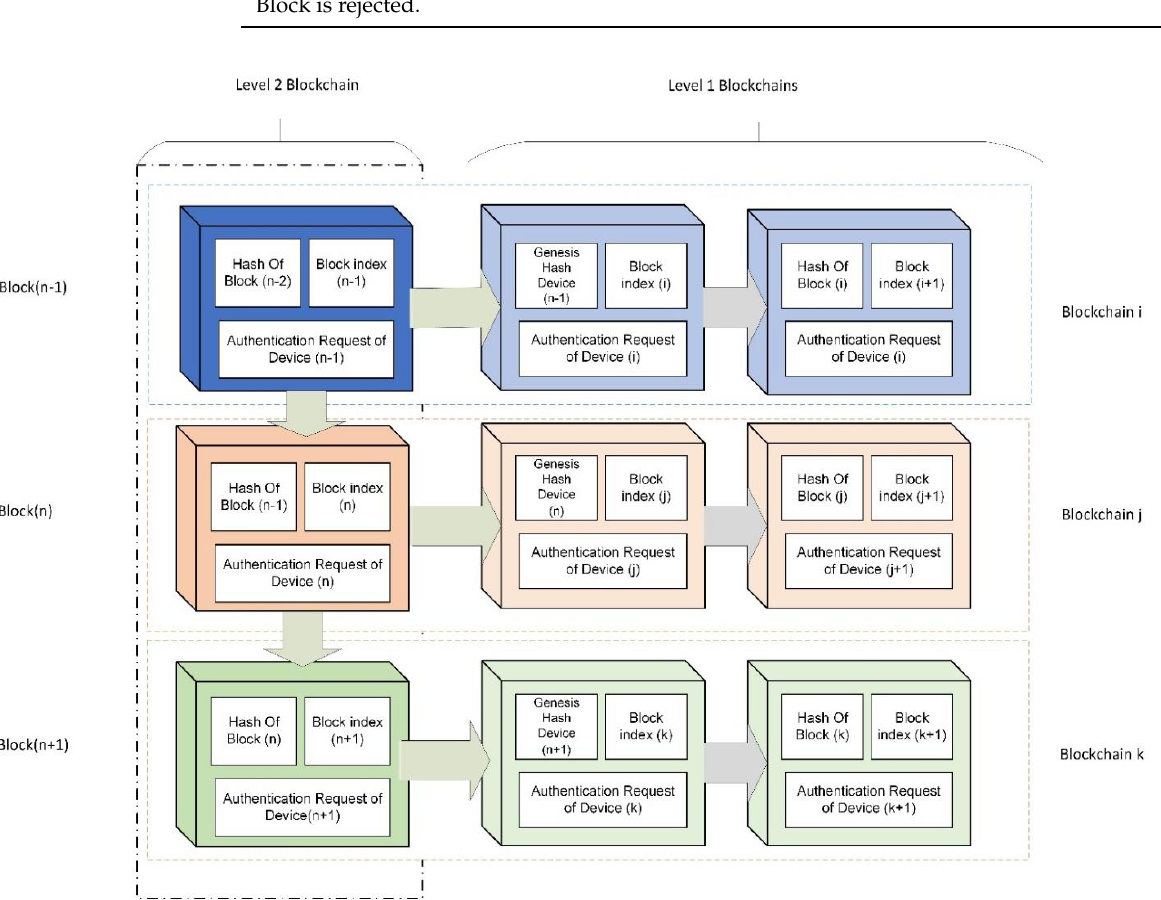
Figure 4. Relation between level-1 blockchain and level-2 blockchain by providing seeding hash from level-2 blocks to level-1 blocks.